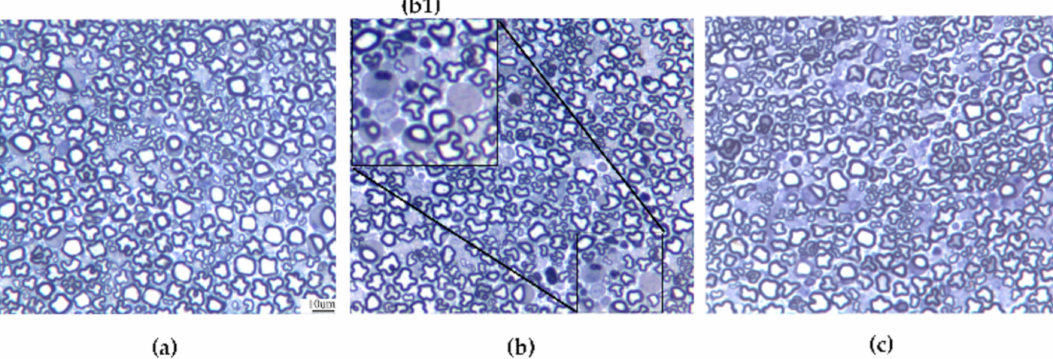
Figure 5. Representative images of caudal nerve samples from a control ( a ), OHP-treated mice ( b ), and OHP + PLEDOX 5-treated mice ( c ) at the end of treatment. ( b1 represents a magnification showing degenerating axons) (bar = 10 µ m, insert b1 = X4